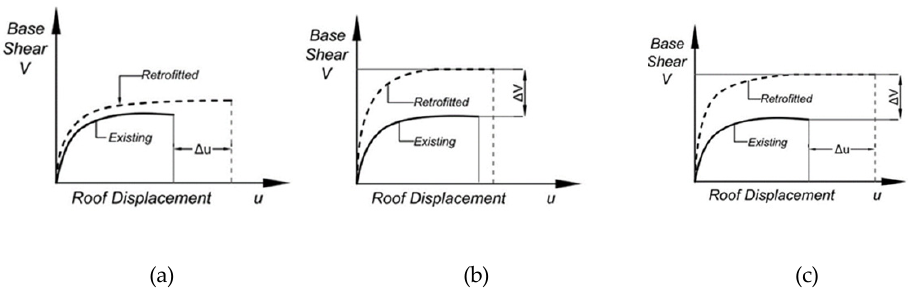
Figure 4. Seismic retro fi tt ing goals for existing buildings: ( a ) ductility enhancement; ( b ) sti ff ness and strength enhancement, and ( c ) sti ff ness, strength and ductility enhancement [30].